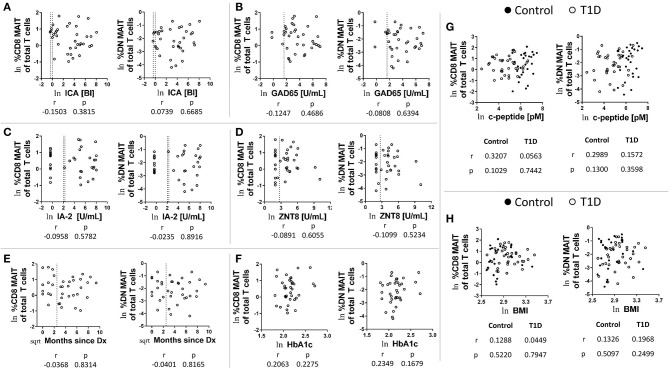
Correlations between CD8 and DN MAIT cell frequencies and T1D-associated parameters. Correlation between CD8 and DN MAIT cell frequency and (A) islet cell antibody (ICA) levels, (B) glutamic acid decarboxylase 65kD autoantibody (GAD65) levels, (C) insulinoma-associated antigen 2 (IA-2) autoantibody levels, and (D) zinc transporter 8 (ZNT8) autoantibody levels, (E) time since diagnosis, and (F) HbA1camong T1D subjects. Correlation between CD8 and DN MAIT cell frequency and (G) c-peptide level and (H) body mass index (BMI) among control and T1D subjects. For (A–H), ln denotes that values were transformed using natural logarithm. For (E), sqrt denotes values were transformed using square root transformation. For (A–D), dotted lines represents manufacturer -defined cutoff values for designating positive or negative status for the given autoantibody. For (E), dotted line represents 1 year from diagnosis. BI, binding index; U/mL, units per mL.